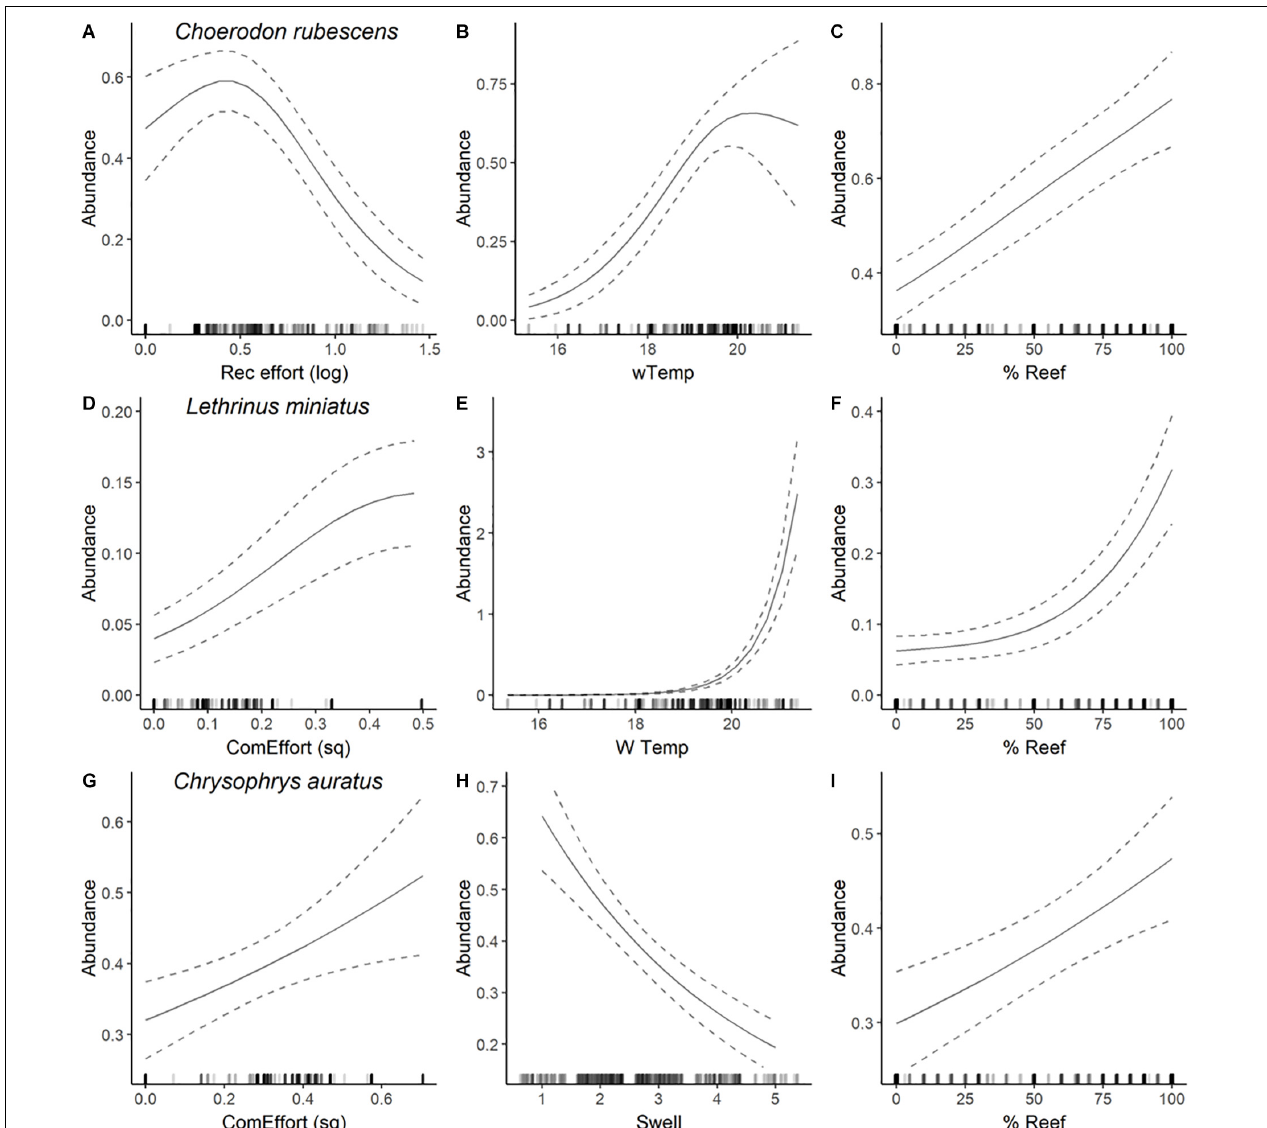
FIGURE 4 | Plots of most parsimonious model found to predict the abundance distribution of C. rubescens (A–C) , L. miniatus (D–F) , and C. auratus (G–I) from full subset GAM analyses (see Table 2 ). Solid lines are fitted gam curves, with dashed lines indicating standard error confidence bands; rug plot is used to indicate the distribution of